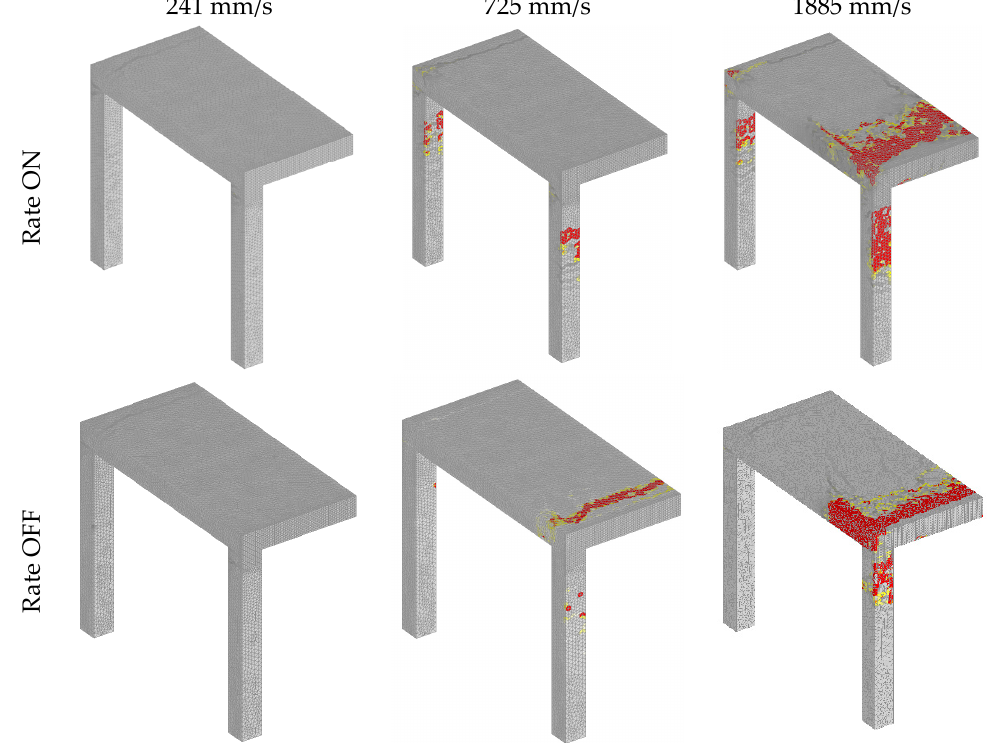
Figure 20. Dynamic analysis, failure modes for different loading rates with and without rate sensitivity (red = maximum principal strain that corresponds to crack width = 3 mm).